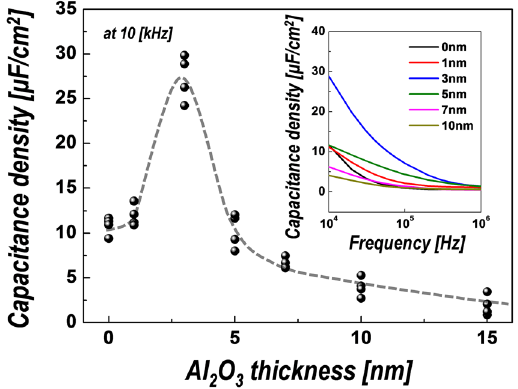
Figure 3. The variation of the capacitance density of two-terminal device with hybrid dielectrics depending on Al 2 O 3 layer thickness with frequency of 10 kHz. Inset: frequency dependence of the capacitance for different Al 2 O 3 thickness.